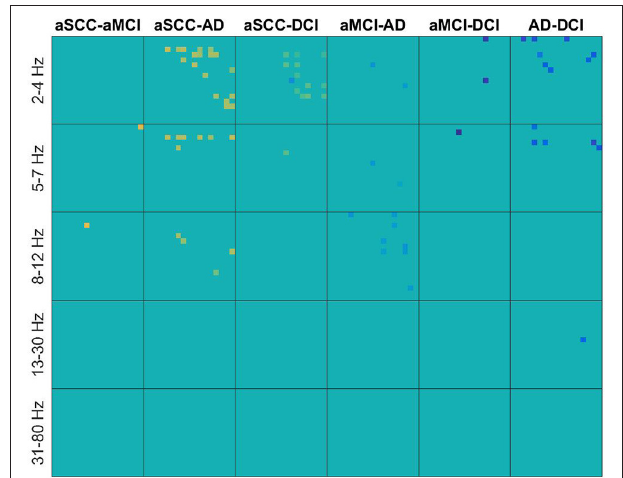
FIGURE 2 | Heatmaps of the t -values of group differences of all electrode × electrode interactions for transfer function, sorted by groups comparisons in columns and frequency ranges in rows. Colors indicate values from − 4.11 (dark blue) over zero (green) to + 5.24 (yellow). All values that were not included for classification were set to zero. If the first group of the group comparison (e.g., aSCC in aSCC-aMCI) has higher values than the second group, this results in a positive t -value, i.e., yellow colors. Electrodes start from top to bottom and from left to right following the order: F3, F4, C3, C4, P3, P4, O1, O2, F7, F8, T3, T4, T5, T6, Fz, Cz, and Pz. AD, Alzheimer’s disease; DCI, depression with cognitive impairment; aMCI, mild cognitive impairment with